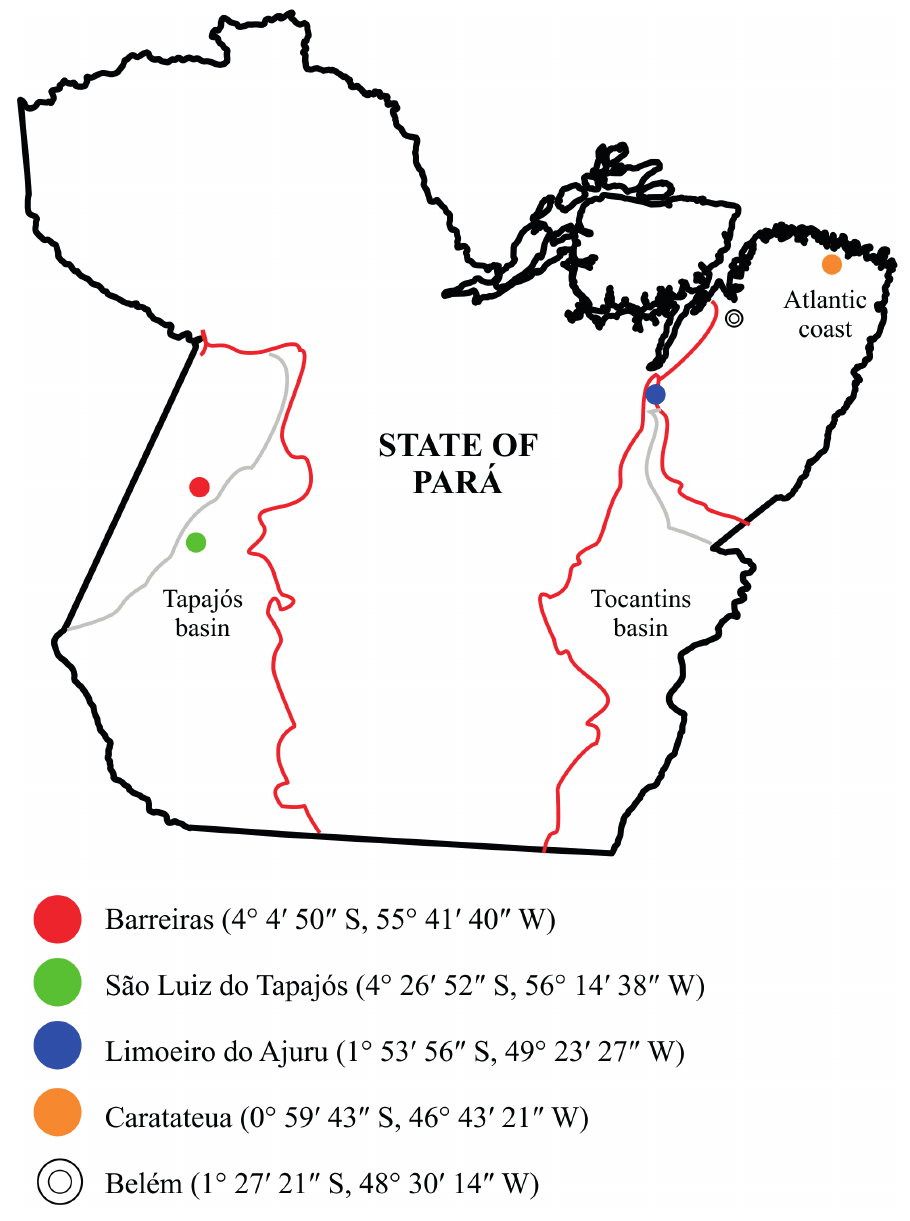
Figure 1 - map of the State of Pará showing the locations studied in this work. The red circle represents the community of Barreiras, situated on the left bank of the Tapajós River. The green circle represents the community of São luiz do Tapajós, situated on the right bank of the Tapajós River. The blue circle represents the community of limoeiro do Ajuru, located in the Tocantins River basin and the orange circle represents the community of Caratateua, located in the Caeté River basin, near the Atlantic Coast of the Pará State. Belém is the town of the Pará